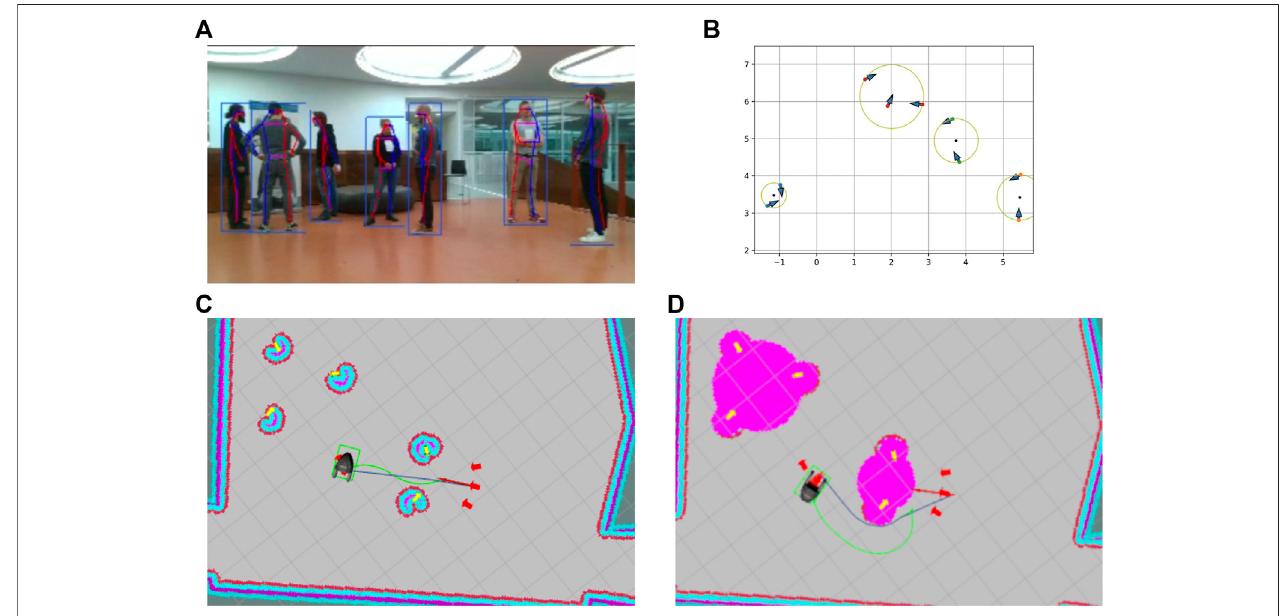
FIGURE7| Groupingandsociallyawarenavigation: (A) robot ’ s fi eldofview; (B) detectedgroups,thebluearrowsindicatedthepeople ’ sposes,circlesindicatethe calculatedo-space,andred arrows theoptimal approachpoints; (C) robot motionplanningusing astandardobstacle-based costmap; (D) robot motionplanningusing an additional socialcostmaplayer onthe topofthe obstacle-based costmap(yellow arrows indicate detected people, red arrows indicate planned approach points, the dark blue path indicates the global plan, and the green path indicates the local plan).